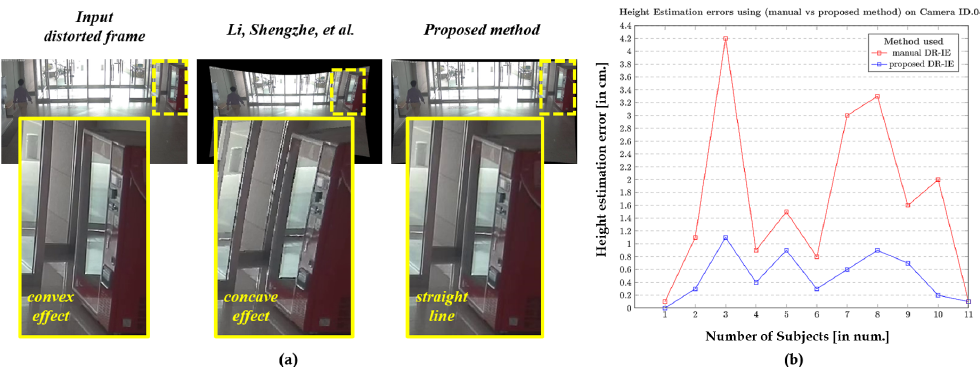
Figure 18. Height Estimation errors using (Li, Shengzhe et al. [31] vs. proposed method) on Indoor camera ID.04: ( a ) Qualitative pixel-consistency. ( b ) Height estimation error plot corresponding to all the 11 subjects.